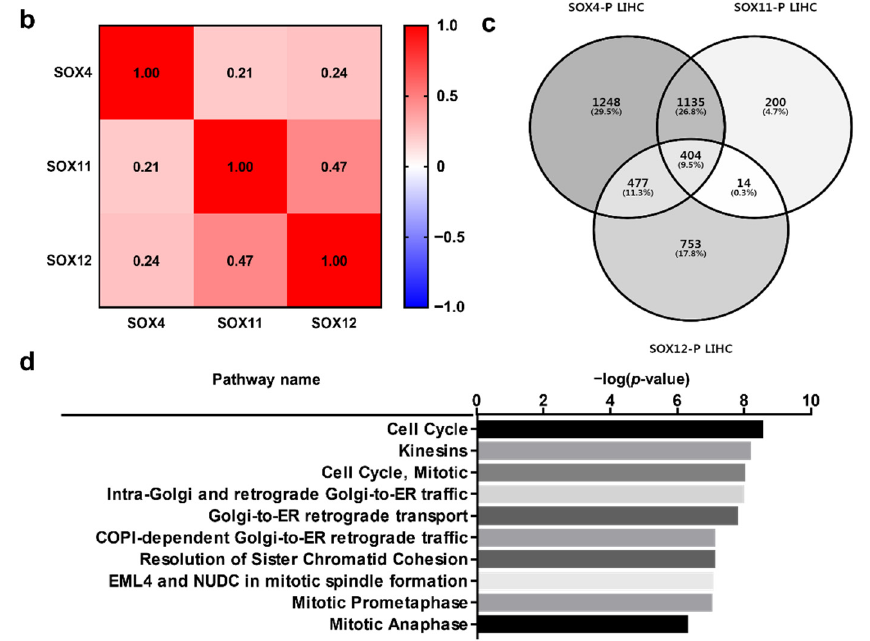
Figure 5. Prognostic value of co-expression of the three SOX genes in liver cancer. Correlation of SOX4 , SOX11 , and SOX12 expression with the prognosis of liver cancer, and analysis of commonly positively correlated genes of the three SOX genes. ( a ) Survival curve comparing patients with high (red) and low (black) expression of each SOX gene using the Kaplan–Meier plotter. The plotters were analyzed for liver cancer. ( b ) Correlation heat map of SOX4, SOX11, and SOX12 expression data, generated using TCGA-LIHC RNA sequencing data from the cBioPortal database. Pearson’s correlation was calculated among the three SOX genes to determine the co-expression pattern of genes in the heat map. ( c ) Venn diagram of the genes positively correlated with the three SOX genes, generated using the TCGA-LIHC transcriptome dataset from the R2 database. ( d ) Reactome pathway analysis of the genes positively correlated with the three SOX genes, using the TCGA-LIHC transcriptome dataset.